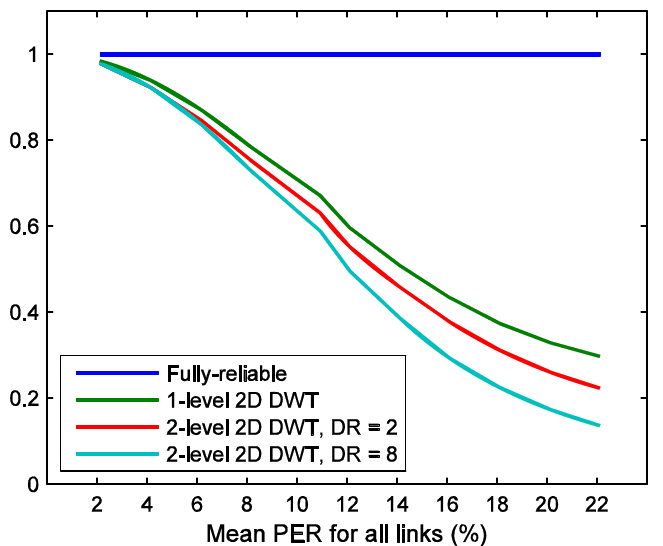
Figure 12. Success ratio versus